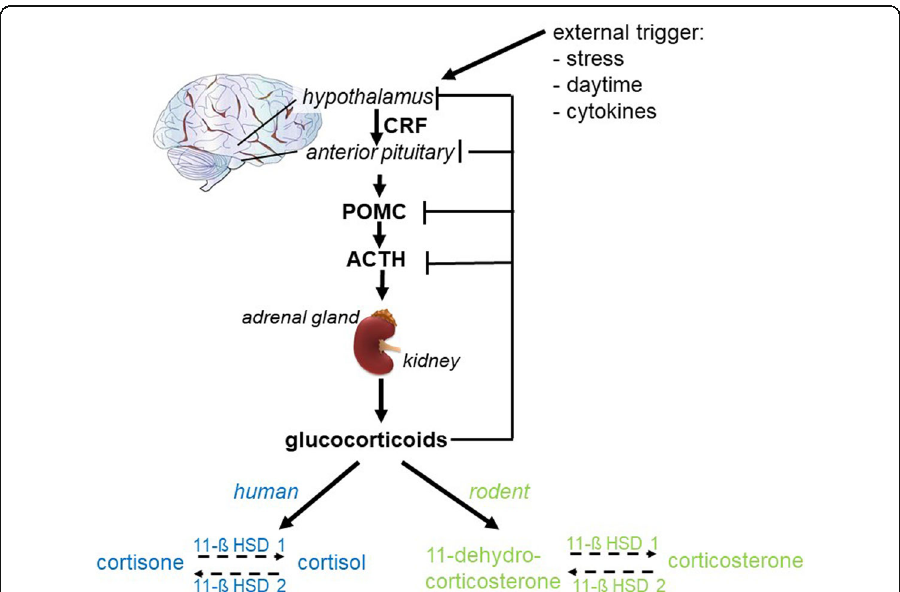
synthesis in the adrenal glands. Glucocorticoids act in a negative feedback mechanism to regulate their own production. In humans, cortisone is converted by 11- β -hydroxysteroid-dehydrogenase-1 (11 β -HSD1) to cortisol and vice versa by 11 β -HSD2. In rodents, the 11-dehydrocorticosterone is converted to corticosterone and vice